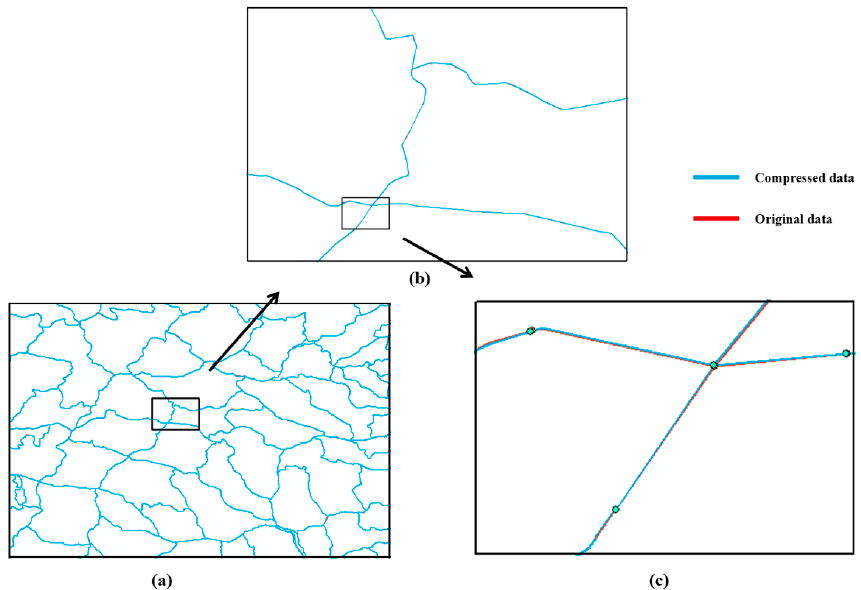
Figure 8. Overlay result of di ff erent scale when n = 15. ( a ) at the display scale of 1:1,000,000; ( b ) at the display scale of 1:100,000; ( c ) at the display scale of 1:25,000.